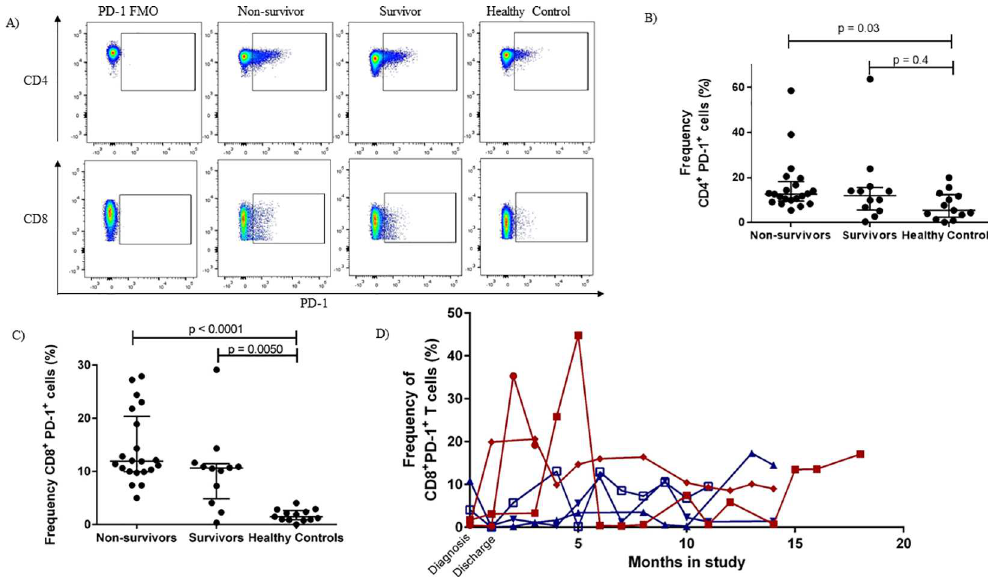
Fig 4. T cells in eBL patients have higher PD-1 expression than in healthy controls. Gating strategy for the identification of PD-1 + cells (A). Frequencyof CD4 + and CD8 + PD-1 + cells at the time of diagnosis in eBL non- survivors, eBL survivors and healthycontrols (B and C, respectively). In generalPD1 expressionon CD4 and CD8 T cells was higherin eBL non-survivors comparedto age-matched malaria exposedyet healthcontrols. eBL survivors had intermediate levels of PD1 expressedon their CD4 T cells yet levels as high as non-survivors for their CD8 T cells. Patients who relapsed tended to have peaks of elevated CD8 + PD-1 + frequencies over time (D). Designatedwith a red ♦ = BL001 (relapse), designated with a red ● = BL002(relapse),designatedwith a red ■ = BL003 (relapse),designated with a blue ▲ = BL004 (event-free survivor), designated with a blue ▼ = BL005 (event- free survivor) designatedwith a blue ■ = BL006 (event-free survivor). FMO; Fluorescence Minus